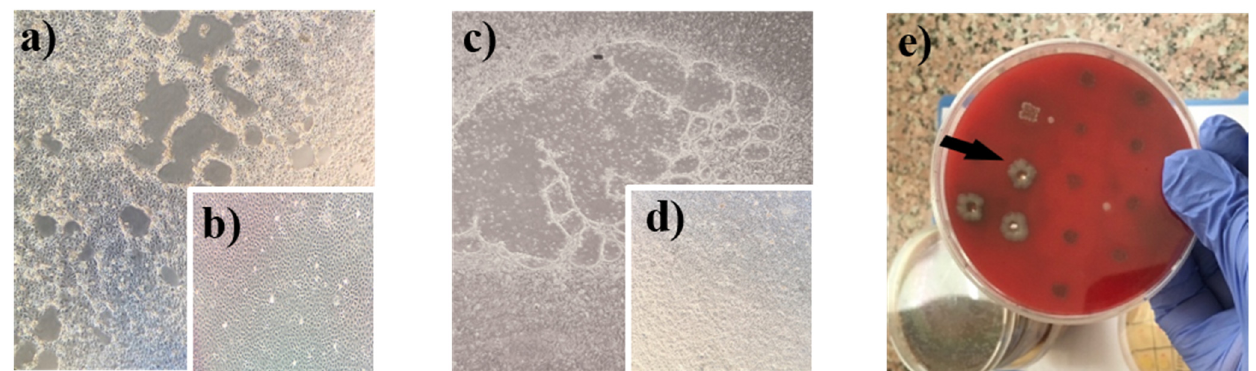
Figure 2. Isolation of infectious diarrheal pathogens from clinical samples. Bovine rotavirus caused the CPE on MA-104 cell monolayers ( a ) and mock-infected cells were intact ( b ). Coronavirus-induced CPE on MDBK cells ( c ) when compared to the mock-infected monolayer ( d ). The black arrow shows the colony picked ETEC K99+ on the solid blood agar dish ( e ).